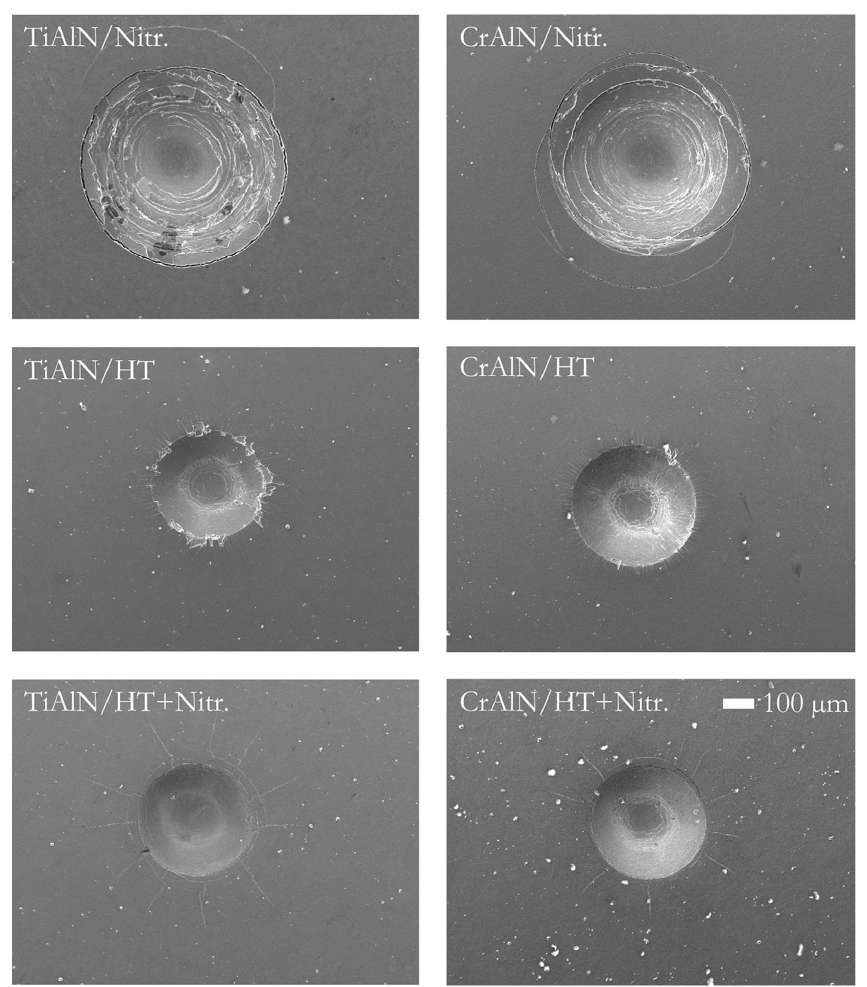
Figure 10. SEM micrographs of the Rockwell C adhesion test indents at 1 kN on the coating/substrate compounds.